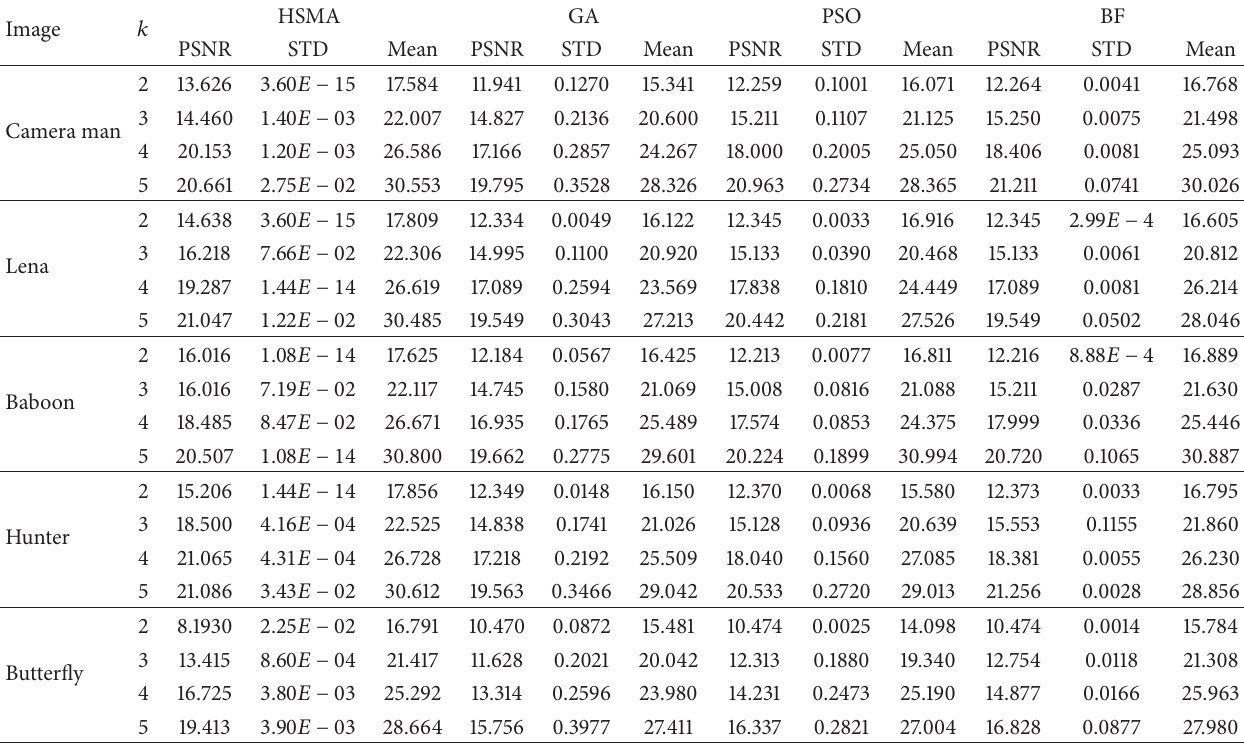
Table 17: Comparison between HSMA GA, PSO, and BF, applied over selected test images using Kapur’s method.